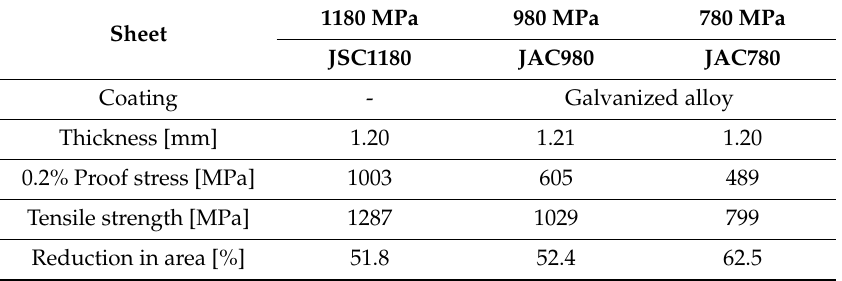
Table 1. Material properties of ultra-high strength steel and high strength steel sheets.